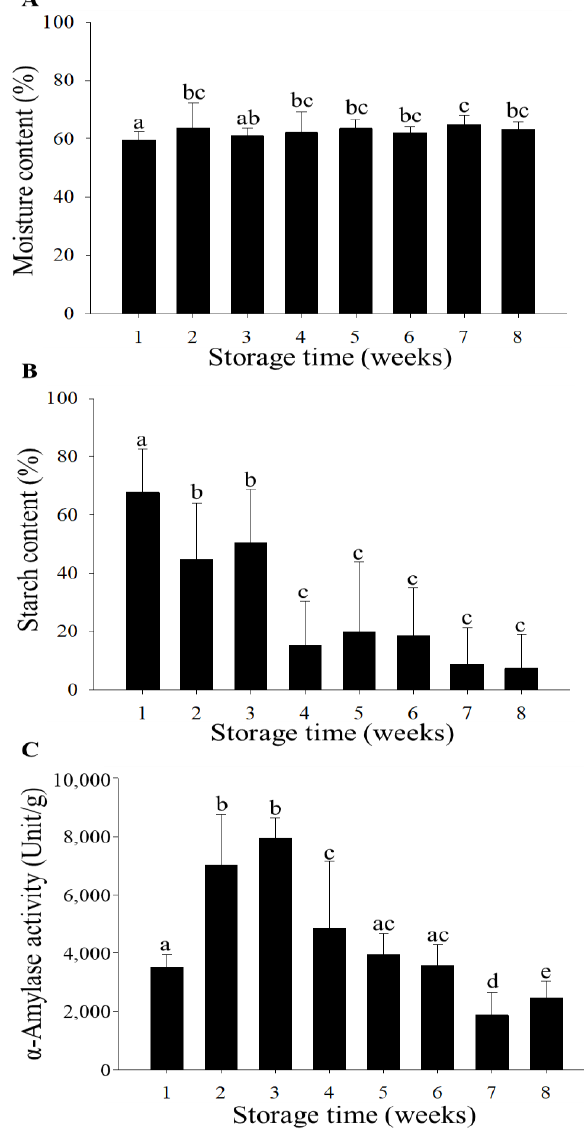
Figure 3. Changes in internal quality in terms of ( A ) moisture, ( B ) starch, and ( C ) α-amylase content of sweet potatoes during storage ( p < 0.05). The data were analyzed using analysis of variance (ANOVA) followed by Duncan’s multiple range test ( p < 0.05) using SPSS software (SPSS, Chicago, IL, USA). The different letters (a, b, c, d, e) describe great differences for each internal